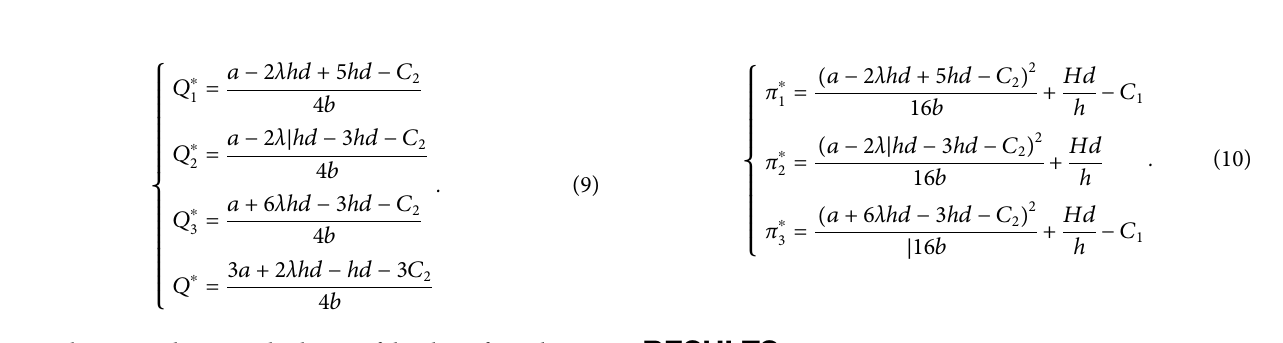
FIGURE 1 | The revenue, costs, and variable returns of three different kinds of enterprises implementing